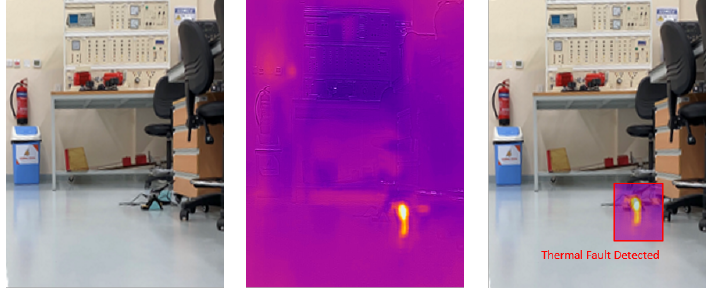
Figure 21. Thermal anomalies detection in lab environment